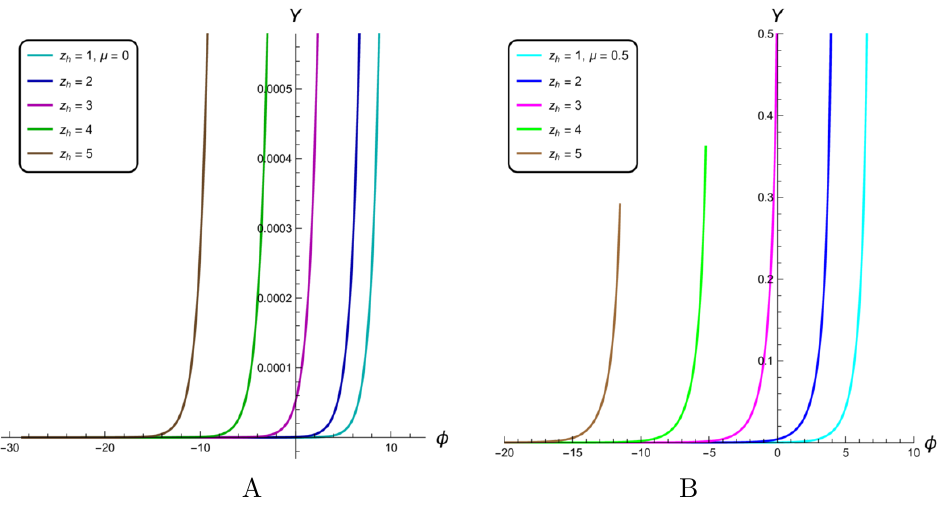
Figure 14 . The function (cid:12) ( H ) in isotropic and anisotropic (cid:23) = 4 : 5 cases.